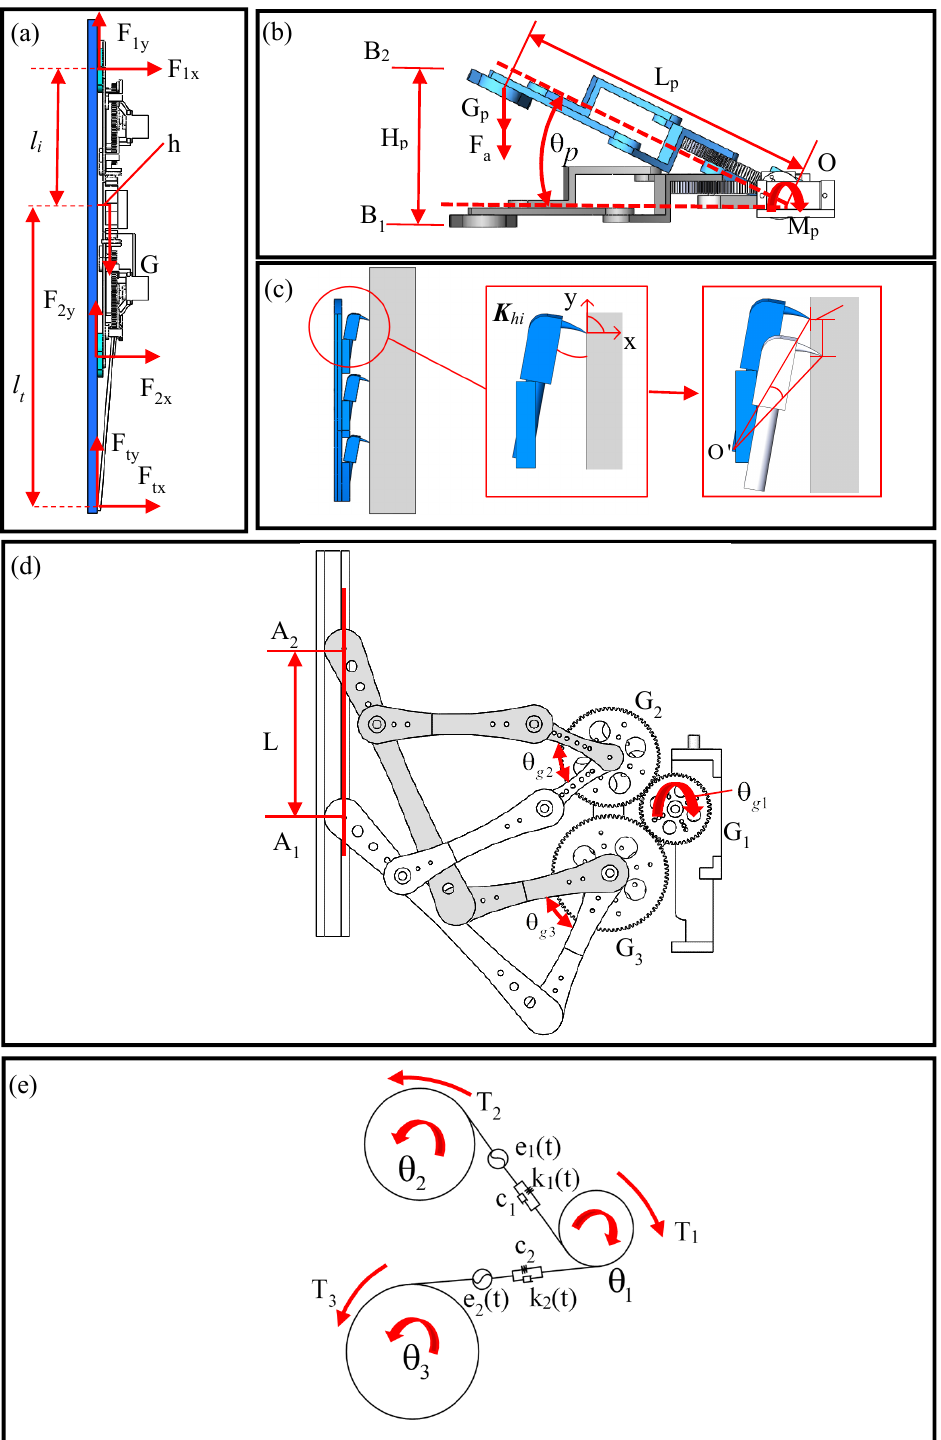
Figure 2. ( a ) Force analysis of the wall-climbing robot climbing on the wall, ( b ) force analysis of the robot’s palm lifted to detach off the surface, ( c ) force analysis of the robot’s palm adhere to the surface, ( d ) the motion analysis of the robot’s palm for climbing, ( e ) the dynamic mechanics’ mode of the transmission system.